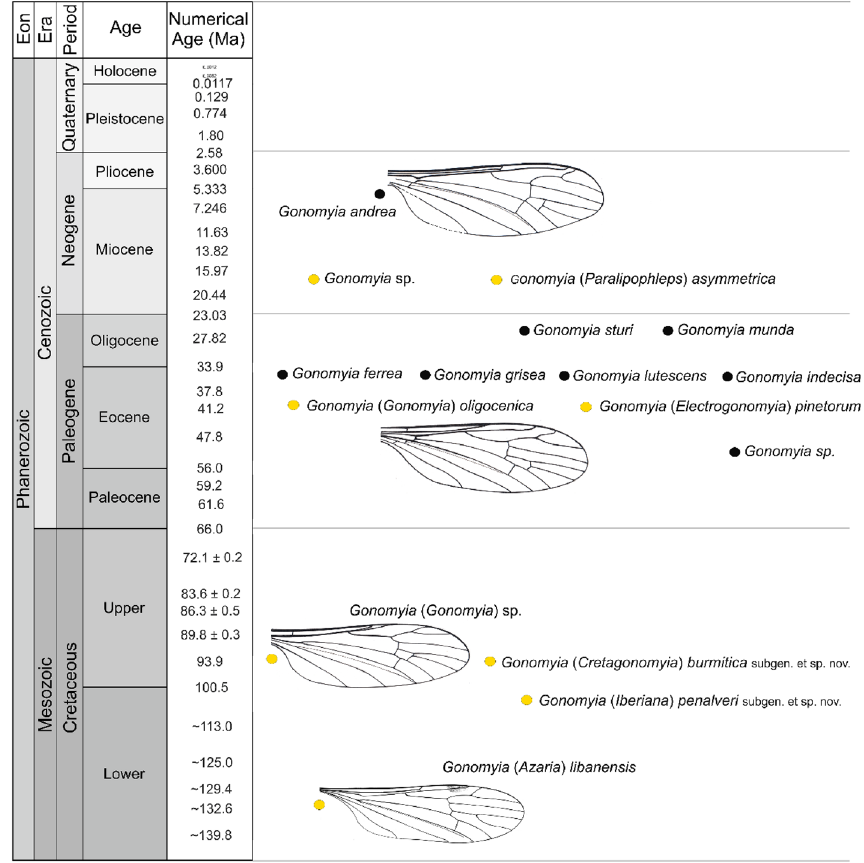
Figure 8. Chronostratigraphic distribution of the Gonomyia Meigen 1 (Diptera: Limoniidae), fossil